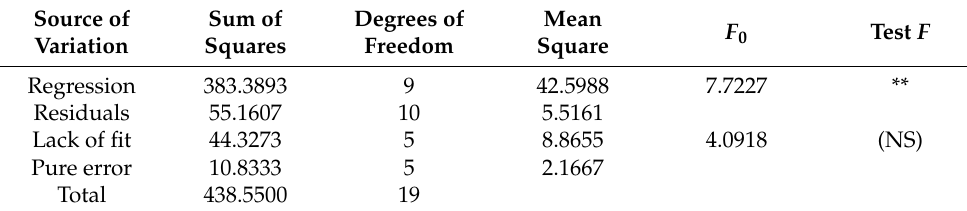
Table 8. Analysis of